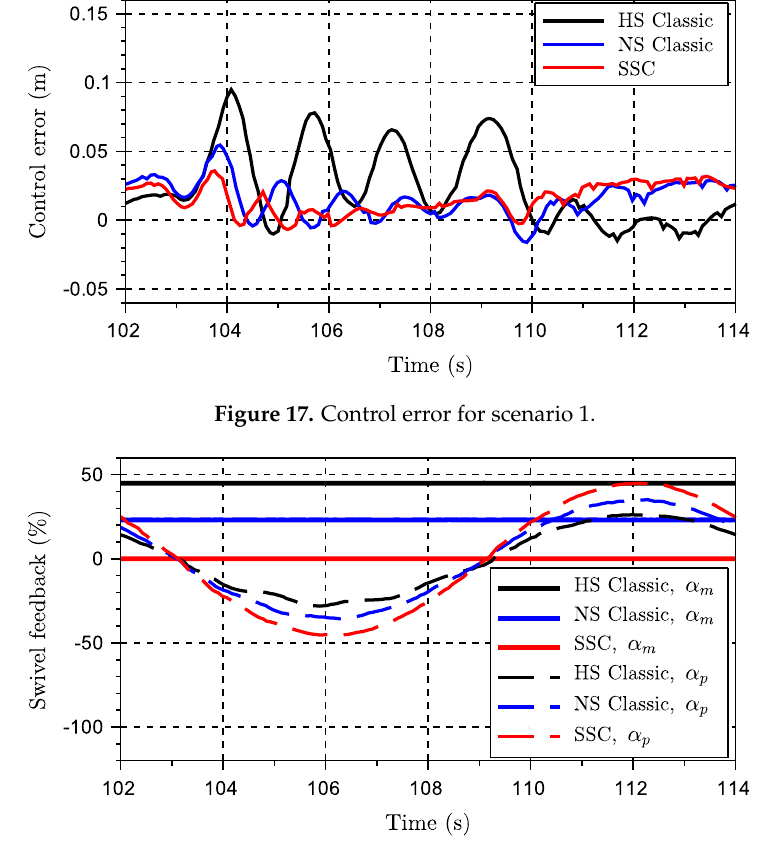
Figure 18. Pump and motor displacement settings for scenario 1 (0% for the motor means maximum